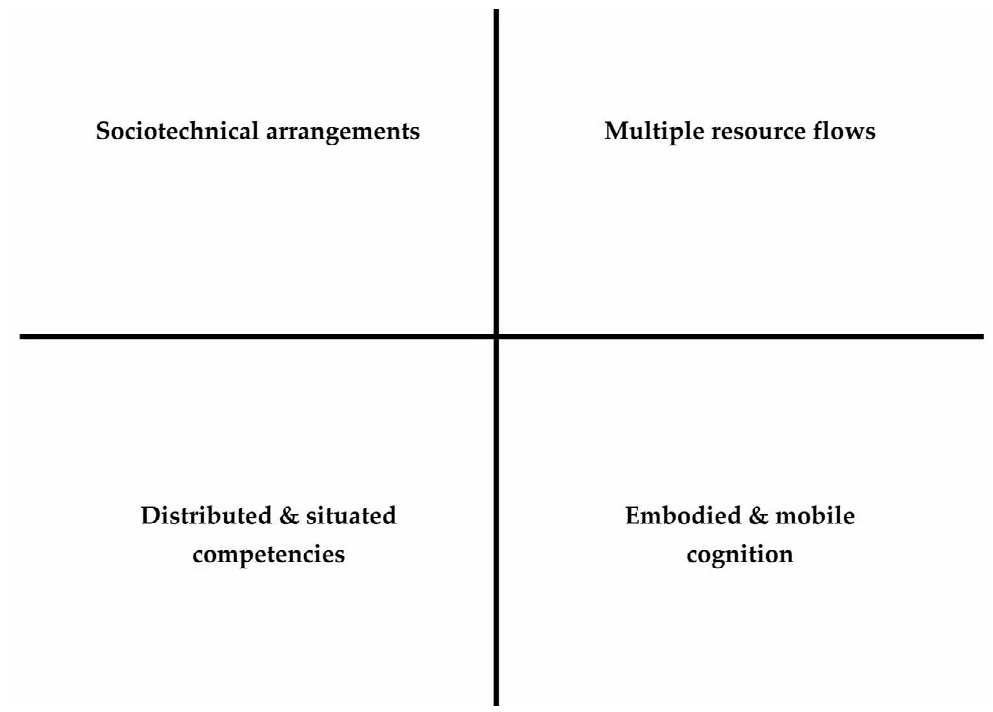
Figure 7. Framework to corroborate embodied cognition in water provision